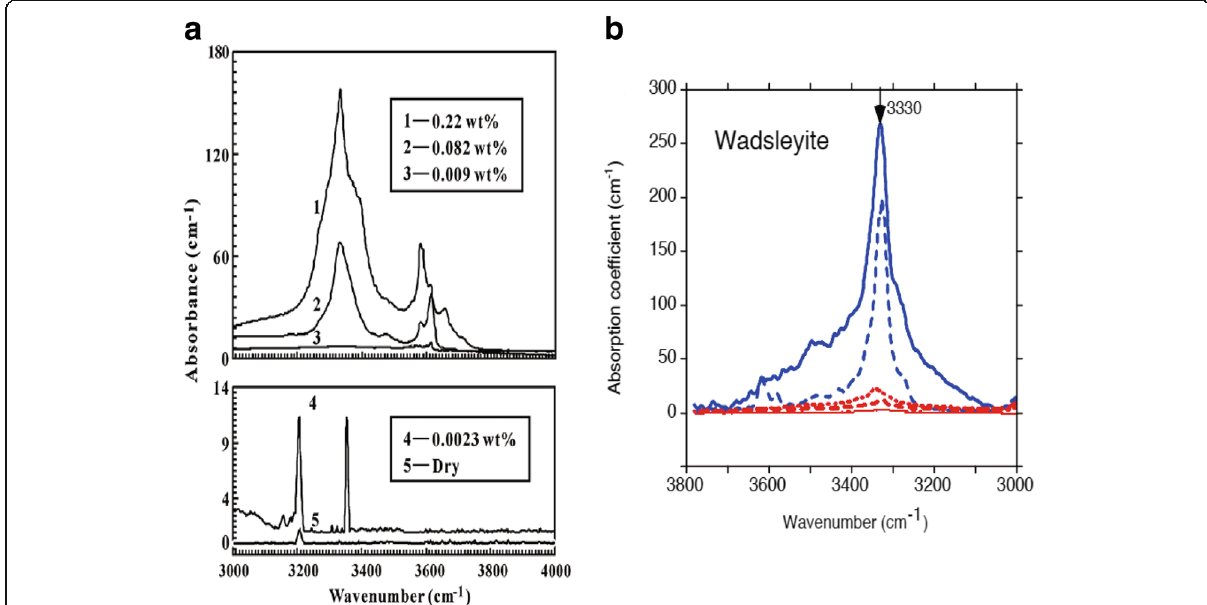
Fig. 5 A comparison of infrared absorption spectra. a Infrared absorption spectra of wadsleyite from (Dai and Karato 2009b). The peak position of infrared absorption changes at low water content. b Infrared absorption spectra of wadsleyite from Yoshino et al. (2008). There is no evidence for the shift of absorption peak at low water